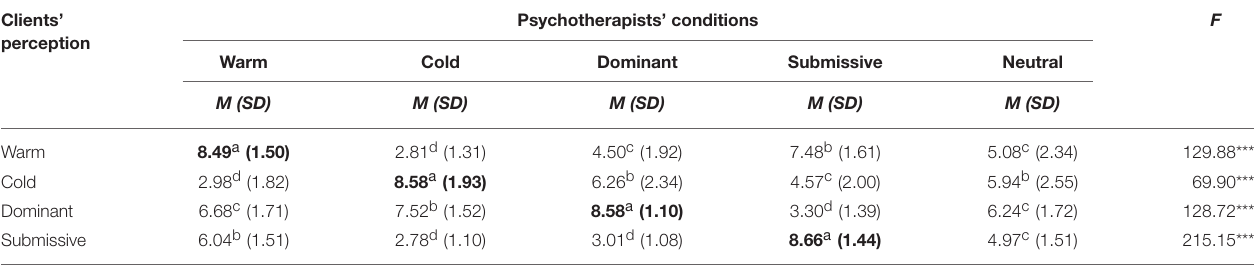
TABLE 1 | Means (SDs in parentheses) of manipulation check ( N = 75): perception of “psychotherapists’ conditions” (within-subjects). Clients’ perception